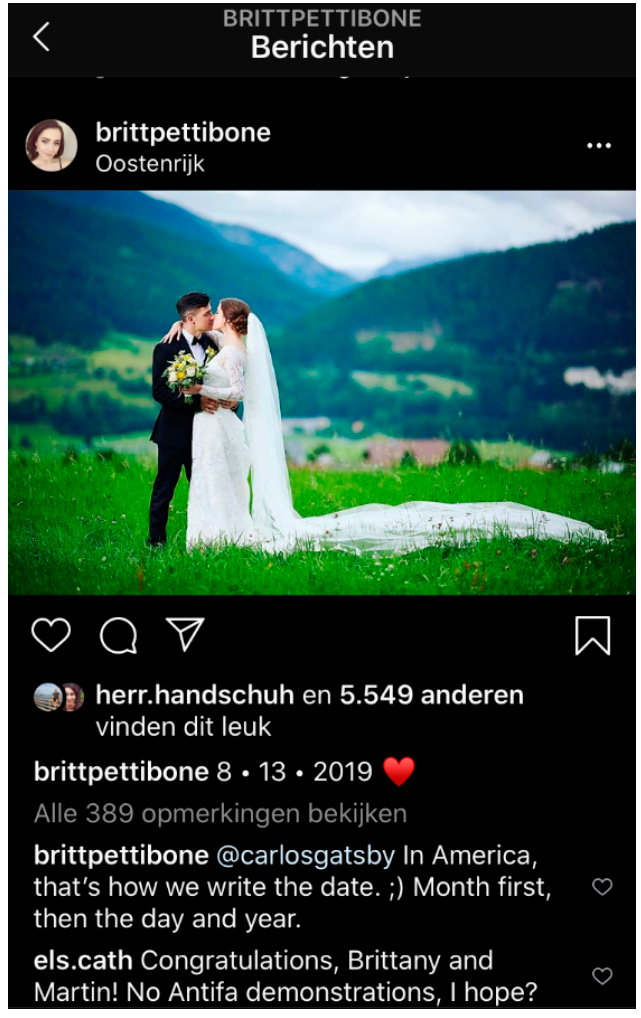
Figure 8. Marriage picture of Martin Sellner and Brittany Pettibone.